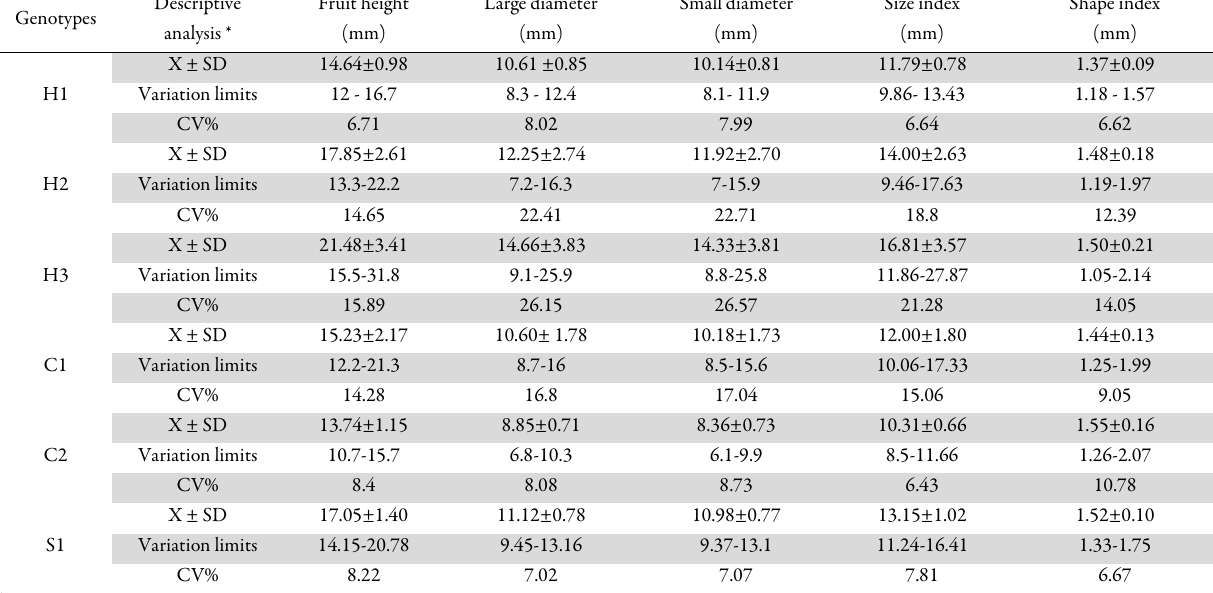
Table 1. Fruit characteristics of six selected cornelian cherry ( Cornus mas L.) genotypes Genotypes